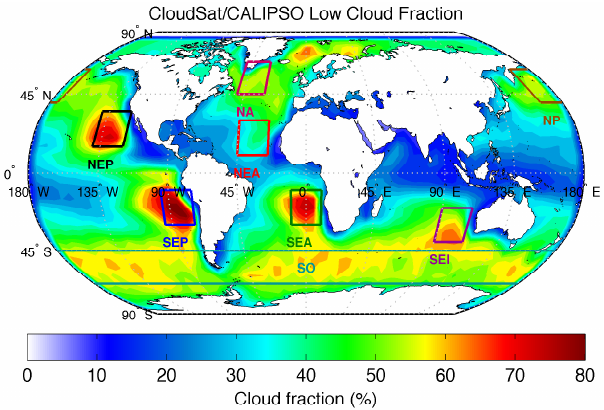
Figure 2. Global distribution of annually averaged low-cloud frac- tion from 5 years of CloudSat/CALIPSO data from 2006 to 2011. The colored rectangular boxes mark typical regions with persis- tent low-cloud amounts. The regions are Northeast Pacific (NEP), Southeast Pacific (SEP), Northeast Atlantic (NEA), Southeast At- lantic (SEA), Southeast Indian Ocean (SEI), North Atlantic (NA), North Pacific (NP) and Southern Ocean (SO). The locations of the displayed regions are adopted from Klein and Hartmann (1993) and are specified in Table